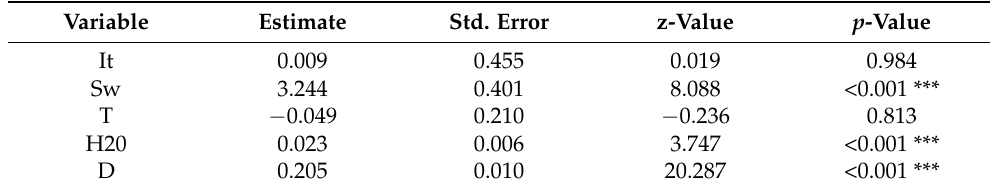
Table 7. Statistical analysis of the timing of leaf senescence on the mother shrubs in the autumn of 2020. In the model, the Belgian provenance is the standard to which the Italian (It) and Swedish (Sw) provenances are compared, and for the treatment in 2018 (T), the control is the standard to which the water limitation is compared.